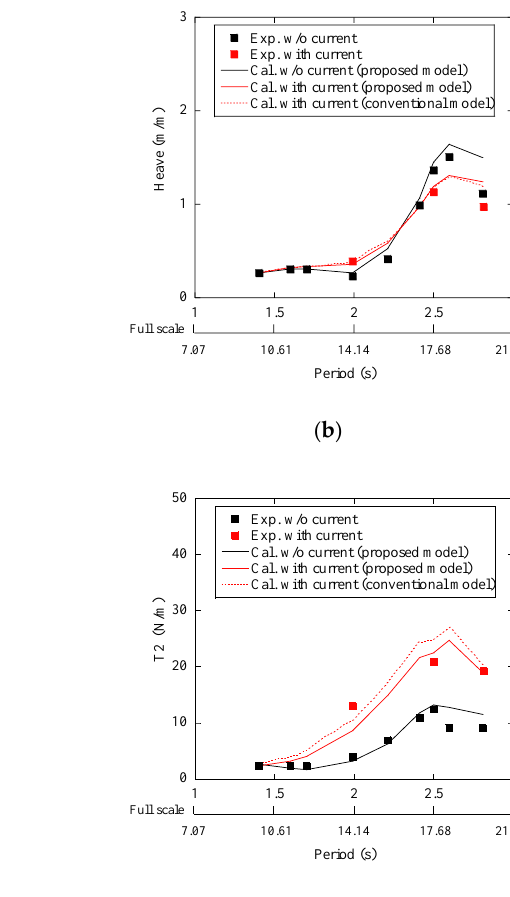
( d ) Figure 14. Comparison of predicted and measured PSD of motions and mooring tension in wave-only and combined wave-current conditions. ( a ) PSD of surge motion, ( b ) PSD of heave motion, ( c ) PSD of pitch motion and ( d ) PSD of mooring tension.